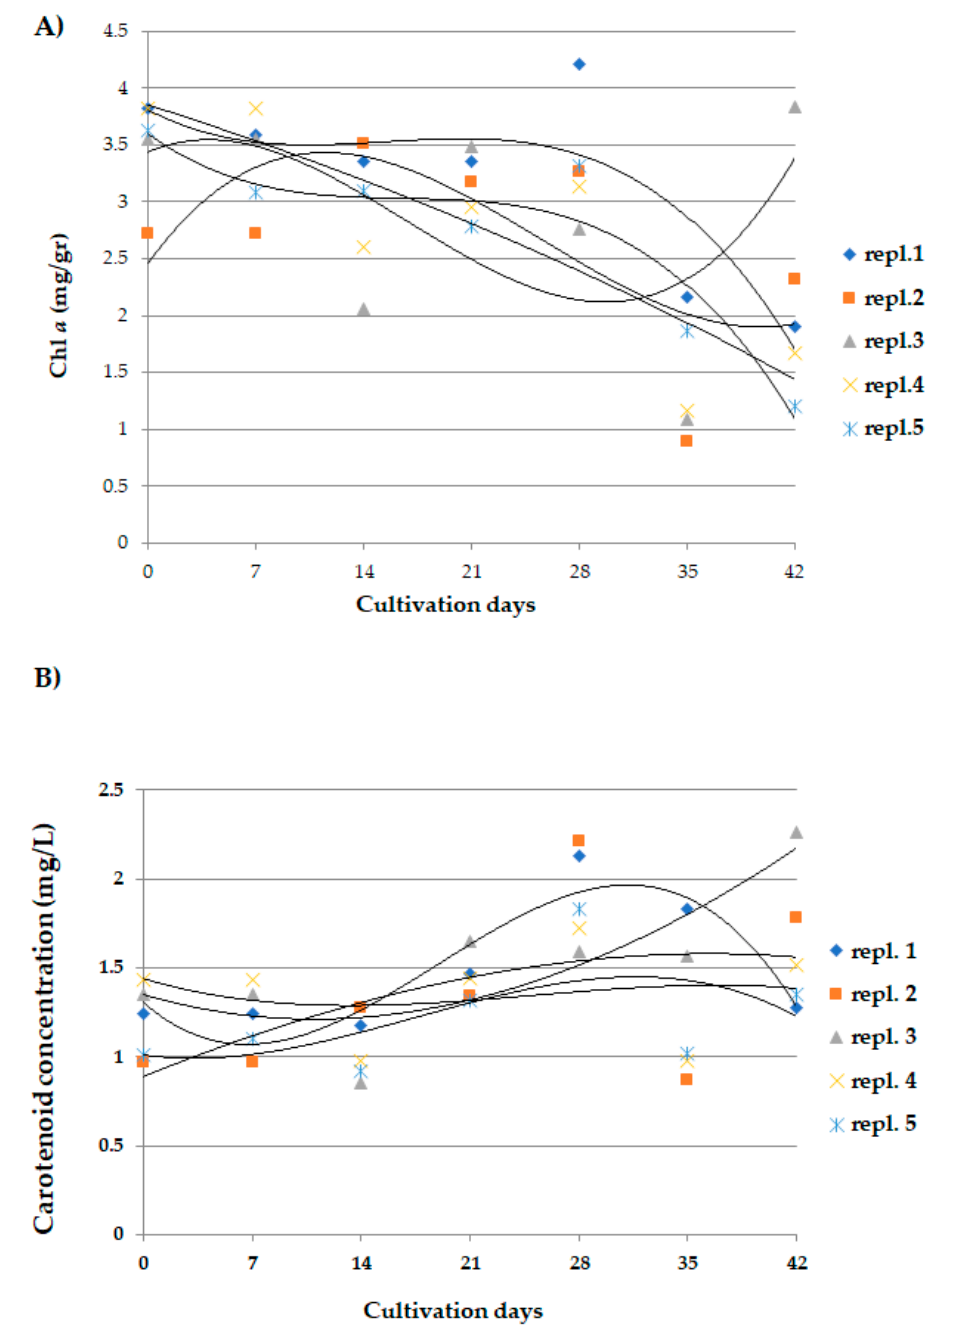
Figure 2. Concentration values of ( A ) Chl a and ( B ) total carotenoids in A. maxima samples, taken every 7 days in 2 reference cultivations. ( A ) p < 0.005 at day 0 and day 35. See Supplementary Table S1B,C for details.